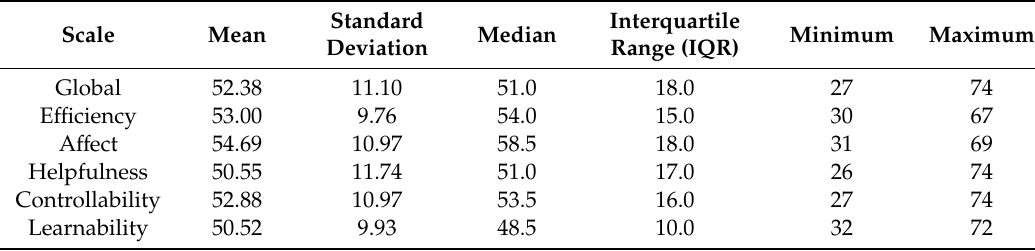
Table 2. Descriptive analysis for SUMI evaluation survey.